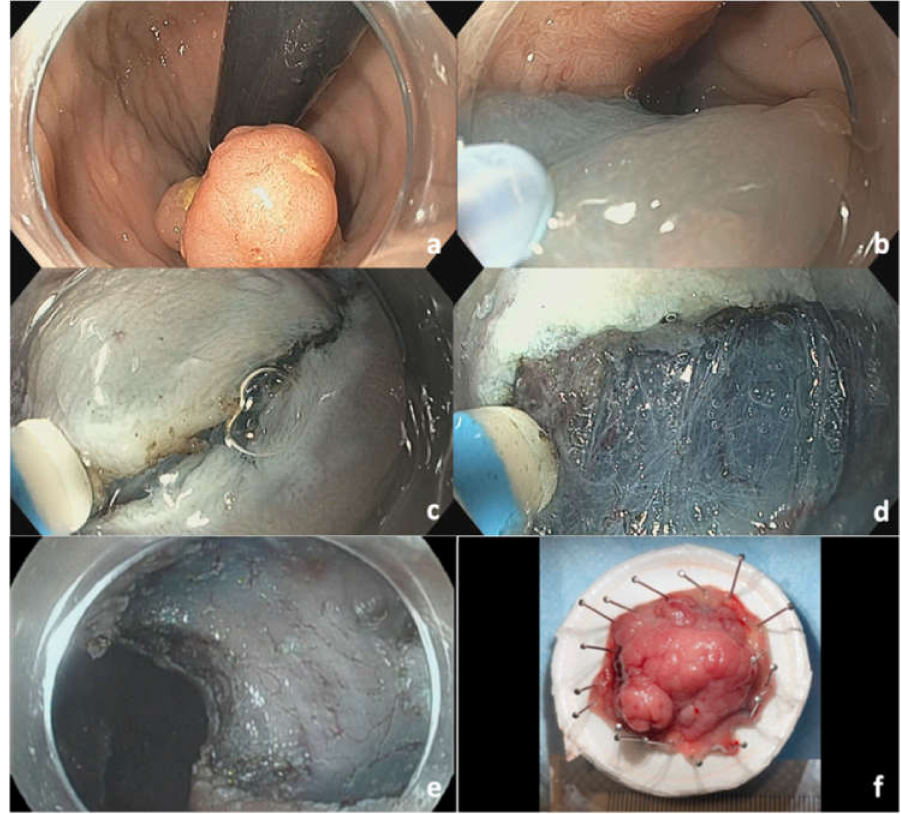
Figure 5. ESD of rectal polyp: ( a ) Rectal polyp seen in retroflexion; ( b ) mucosal injection with viscous solution and methylene blue; ( c ) mucosal incision using DualKnife J; ( d ) submucosal dissection; ( e ) resection site defect; ( f ) final 3 cm Paris classification Isp + IIa LST-mixed granular